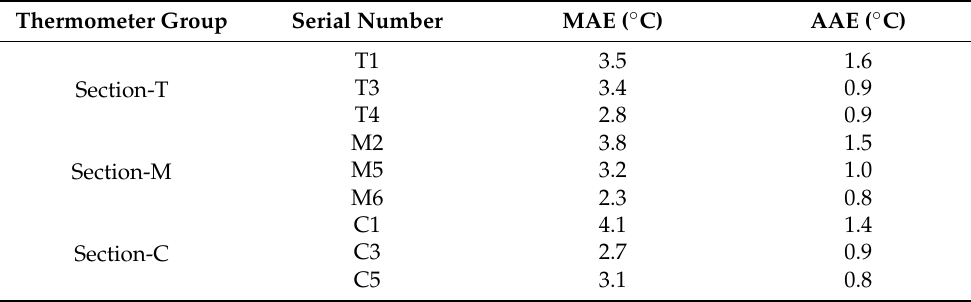
Figure 10. The comparison of experimental and simulated temperatures on the selected days: ( a ) measurement points at Section-T; ( b ) measurement points at Section-M; and ( c ) measurement points at Section-C. Table 1. MAE and AAE between the simulated and experimental